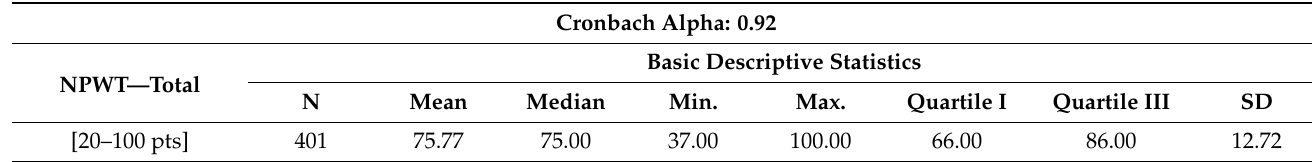
Table 5. Results of the NPWT perception questionnaire—total (sum of 3 domains).